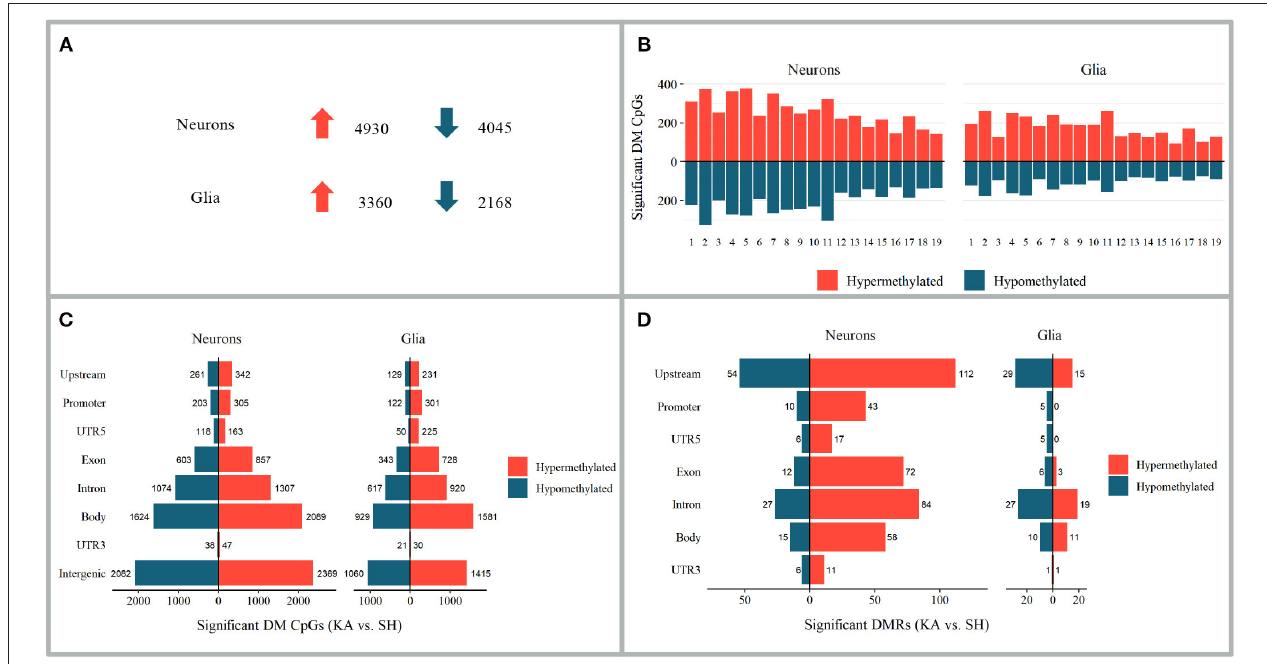
FIGURE 4 | Alterations in DNA methylation 24h after kainate-induced status epilepticus in hippocampi contralateral to injection site. (A – C) Differentially methylated CpGs of the kainic acid group vs. the sham group. (A) Number of differentially methylated CpGs in neurons and glia; upward arrow implies hypermethylation and downward arrow hypomethylation. (B) Chromosomal distribution of differentially methylated CpGs. (C) Distribution of differentially methylated CpGs among genomic features. (D) Distribution of differentially methylated regions among genomic